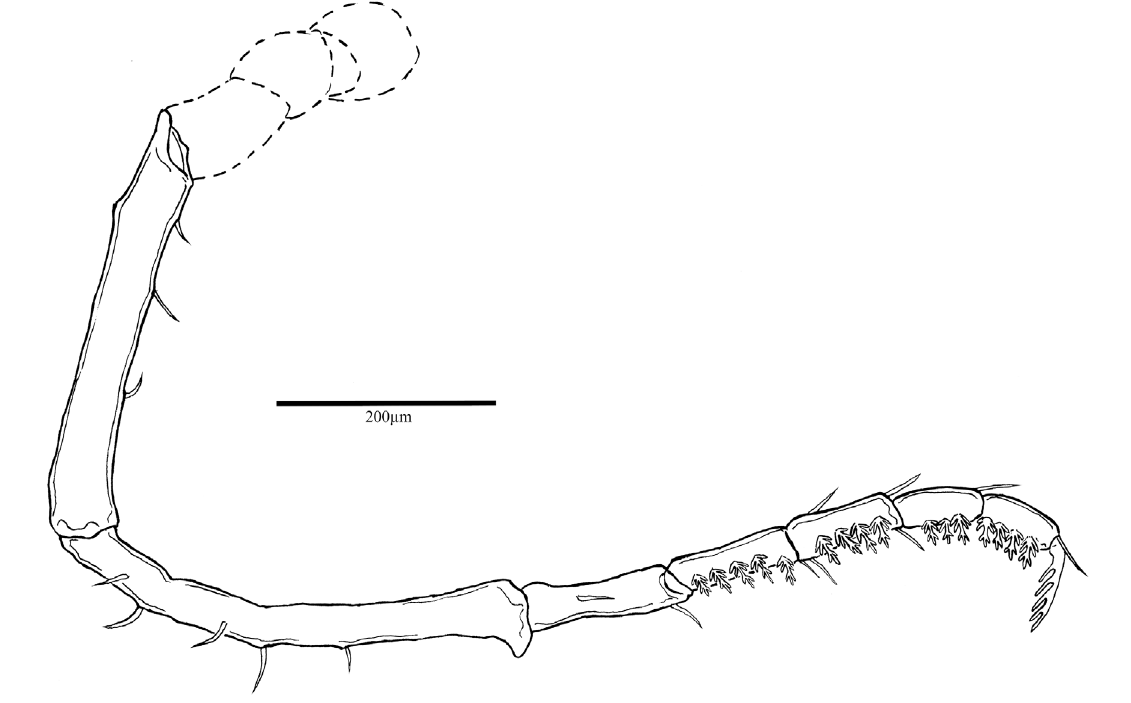
Fig. 16. Nymphon timons sp. nov., paratype, ♂, MNHN-IU-2021-6623.